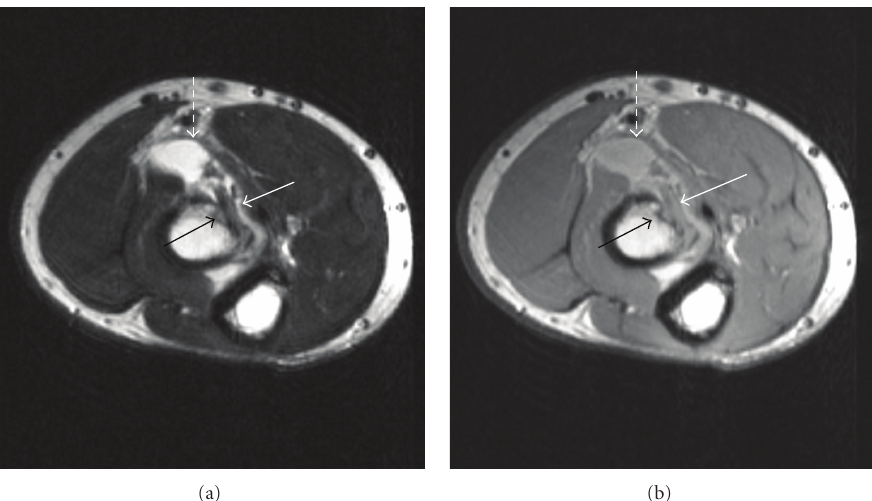
Figure 2: Axial T2 (TR: 3550; TE: 82) (a) and intermediate/proton density weighted (TR: 3550; TE: 16) (b) axial images at the level of the tuberosity demonstrating the high-grade partial tear of the distal biceps tendon (solid white arrow), bursitis (dashed white arrow), and osseous changes (solid black arrow).